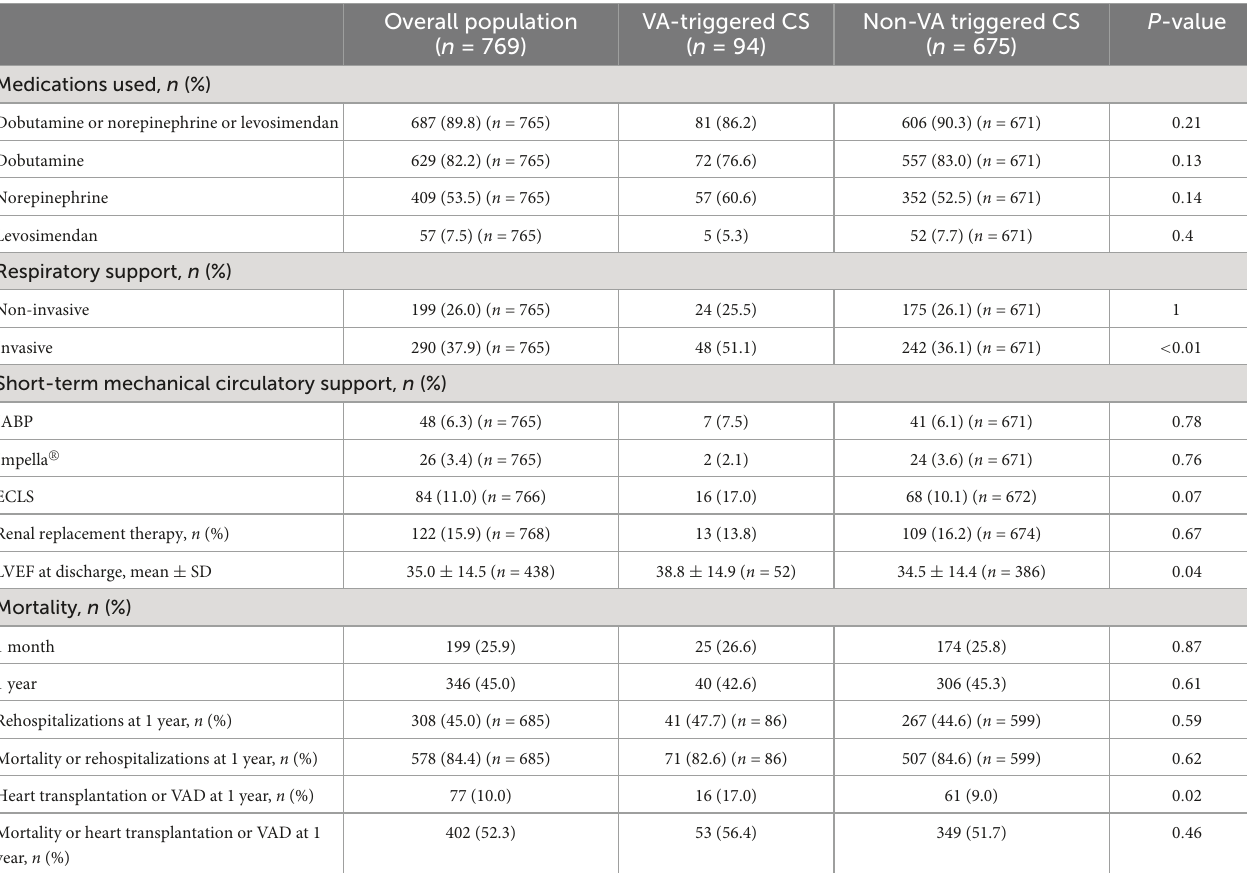
Overall population VA-triggered CS Non-VA triggered CS P -value ( n = 769) ( n = 94) ( n = 675)